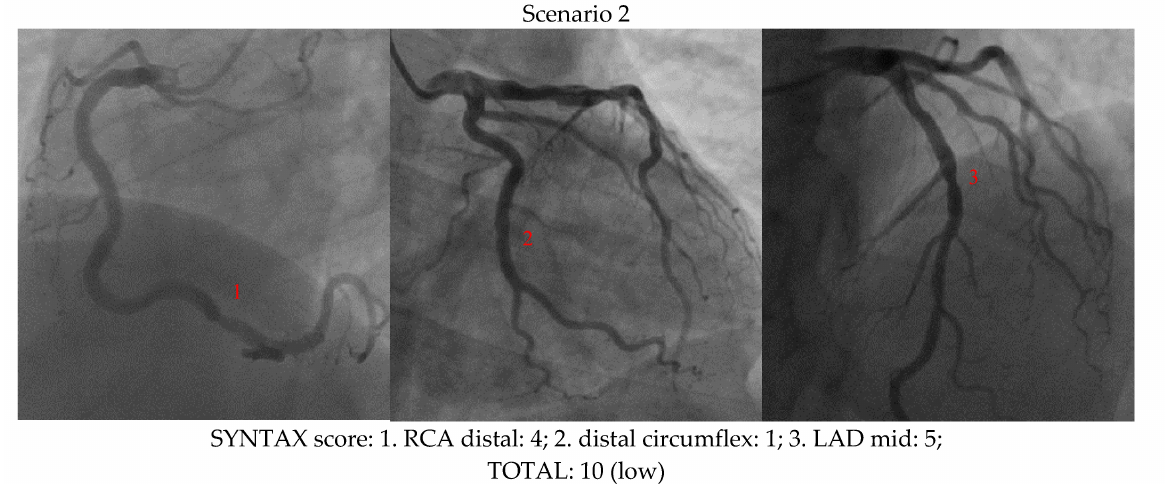
Figure 1. Two scenarios showing how the SYNTAX score was graded in a cardiac examination. The SYNTAX score was graded as 47 ( high ) and 10 ( low ) for scenarios 1 and 2,